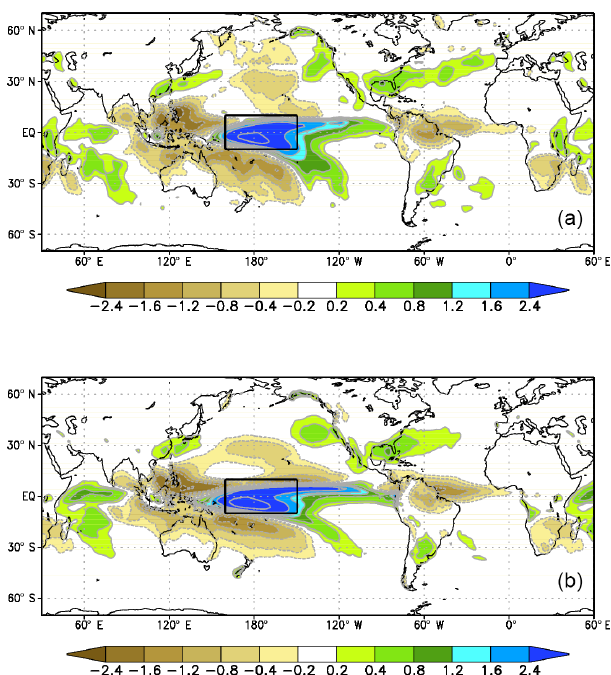
Figure 13. Covariance between normalised DJF rainfall anomaly in the Niño 4w region (black box) and rainfall anomaly elsewhere, following Molteni et al. (2015); (a) GPCP v2.3 data; (b) SEAS5 re- forecasts. Note the stronger signal over the western Indian Ocean in